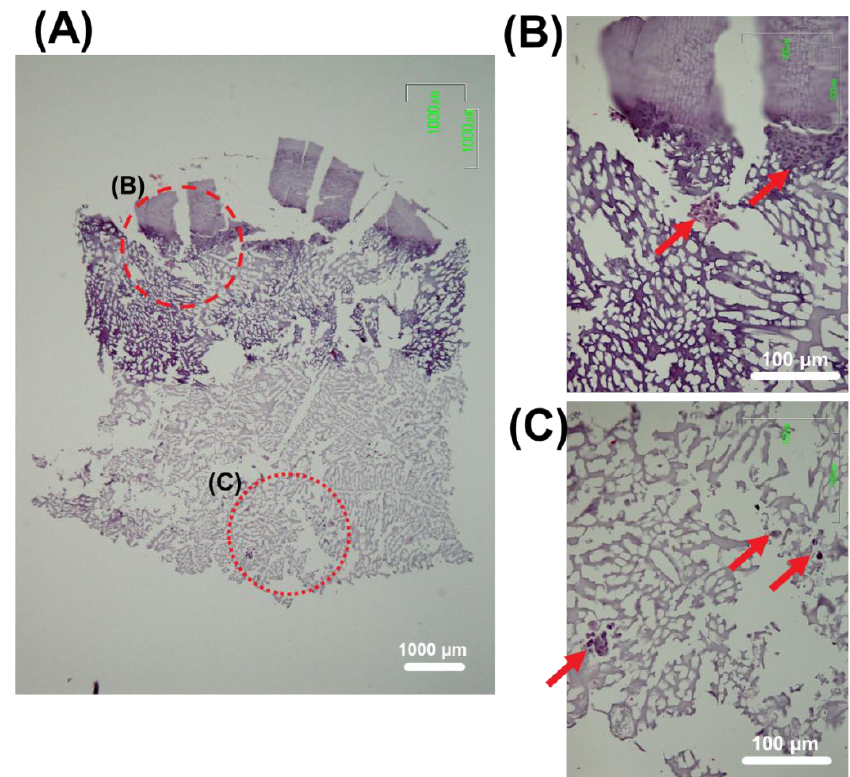
Figure 9. Optical microscopy images of a representative slide of the biomimetic scaffold after 14 days of seeding. ( A ): General view showing the whole piece (40×). ( B ) and ( C ): Magnification (200×) of the dashed and dotted circles, respectively. Cell aggregates are pointed with arrows. H&E staining.